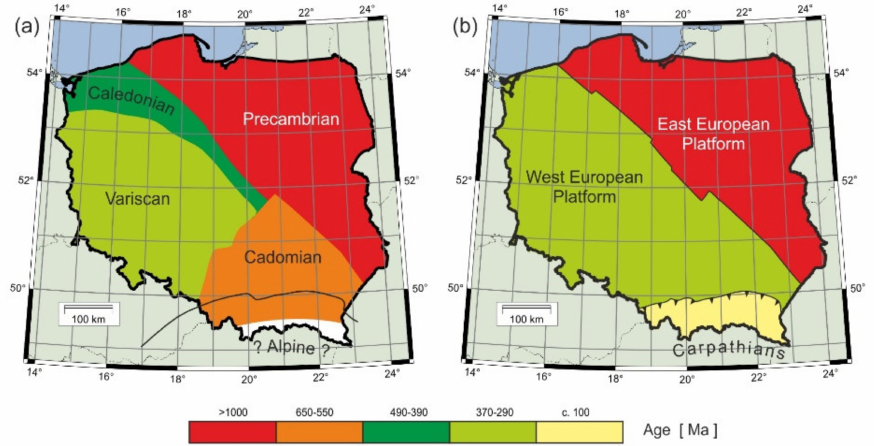
Figure 1. Newly drafted compilation of major division of the Poland area on tectonic mega-units according to ( a ) [6] and ( b ) [19]. Note: The original colors were modified to show both maps in the same common color pattern.